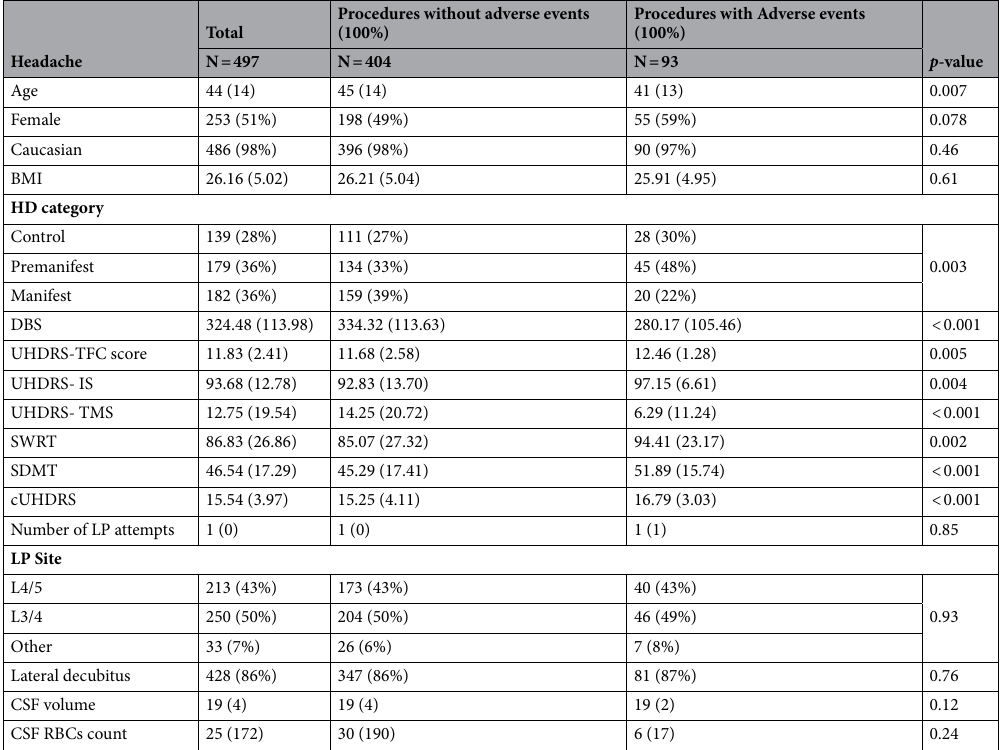
Table 5. Baseline demographics and CSF sample methodology in relation to the development of headache post LP. Continuous variables are reported as mean (standard deviations). Categorical variables are reported as absolute and relative frequencies. BMI body mass index, CAG HTT CAG size, DBS Disease Burden Score, cUHDRS composite Unified Huntington’s Disease Rating Scale, TMS UHDRS Total Motor Score, TFC UHDRS Total Functional Capacity, IS UHDRS Independence Scale, SWR Stroop Word Reading test, SDMT Symbol Digits Modality Test, RBCs Red Blood